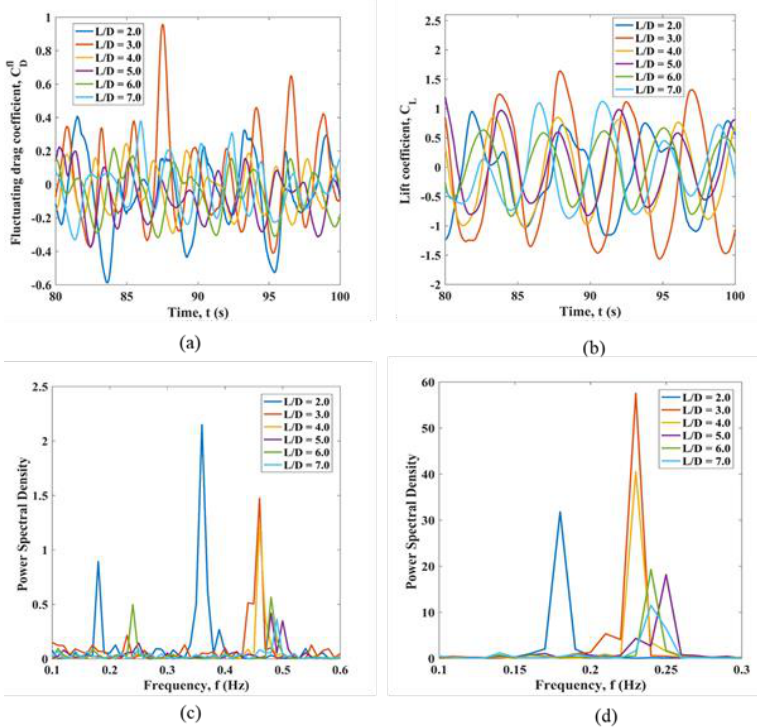
Figure A9. Fluid force coefficients for cylinder 5 immersed in planar sheared flow: ( a ) time history of the fluctuating drag coefficient; ( b ) time history of the lift coefficient; ( c ) the fluctuating drag co–efficient FFT; ( d ) the lift coefficient FFT.